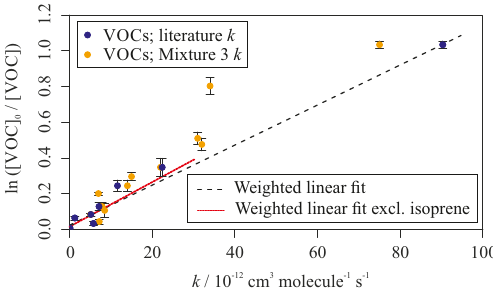
Figure 10. Relative rate plot for ambient air analysis. Compounds with a known rate coefficient are plotted using literature values at 323K. A weighted linear fit of these data was used to generate the black dashed slope with an R 2 of 0.98. A second weighted linear fit, excluding isoprene, is shown by the red dashed slope ( R 2 of 0.71). Some of the compounds do not have literature rate coefficients at 323K but were measured at this temperature elsewhere in this pa- per (see Table 3). Compounds with a rate coefficient derived from Mixture 3 relative rate studies are also plotted (in yellow) to com- pare between the synthetic mixture and ambient air results. Error bars on the y axis, equal to 2 standard errors, are calculated using the standard deviation in depletion factors for each VOC across all samples. Error bars on the x axis are not shown but are typically large (up to